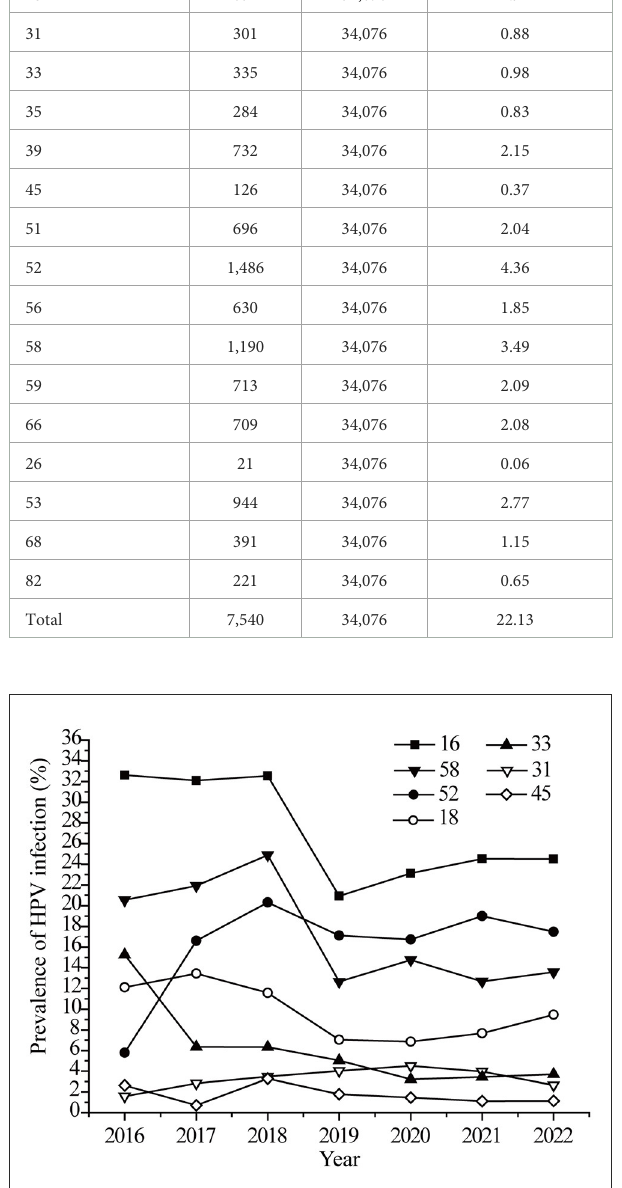
of HPV screening among young people, and the change in HPV infection in individuals aged 20–29 years may be due to the efficacy of the vaccines. Furthermore, the prevalence of HPV genotypes targeted by vaccines was different in individuals aged 20–29 years (Figure 4B). The ratio in positivity of HPV16 in 20–29-year-olds decreased slightly from 2018 to 2022, but the change was not significant ( P =